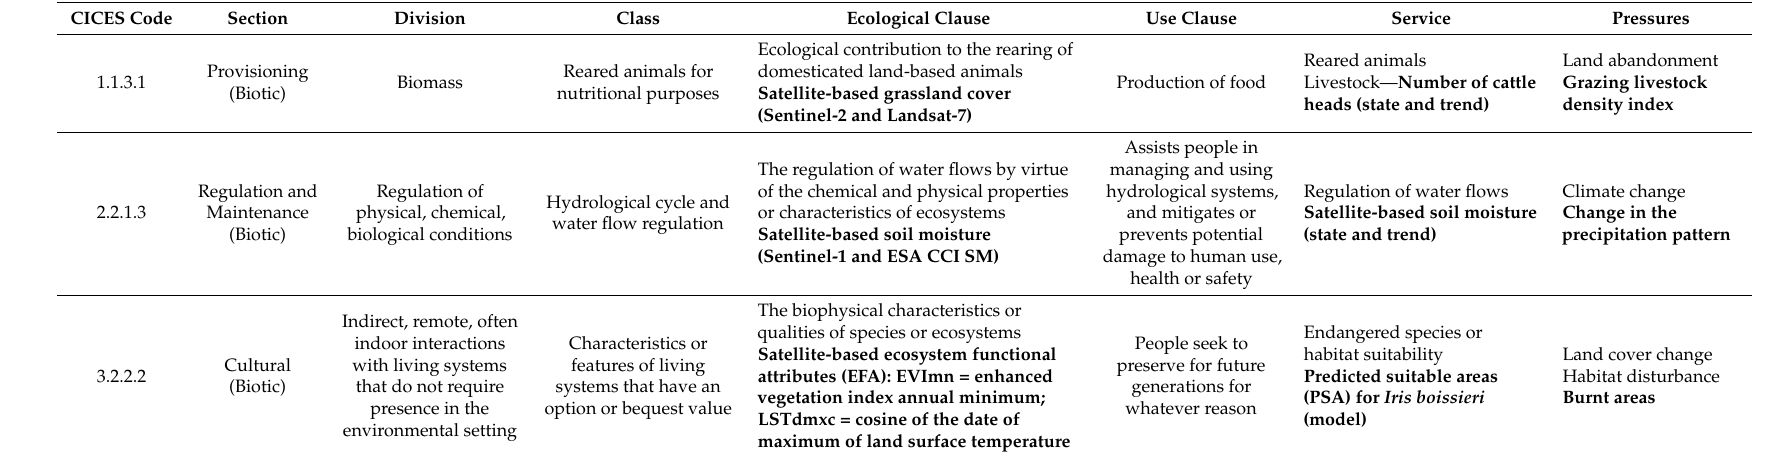
Table 1. Ecosystem services evaluated in PGNP according to the CICES (Common International Classification of Ecosystem Services) classification (v5.1), and their respective indicators used in this study ( bold ), including satellite-based products. The Pressures column is not part of CICES but was included here to list the major socio-environmental stressors for each